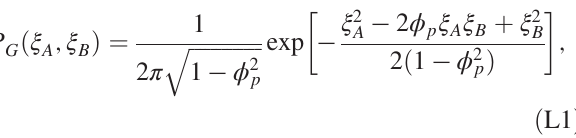
ffiffiffiffiffiffiffiffiffiffiffiffiffiffi 1 − ϕ